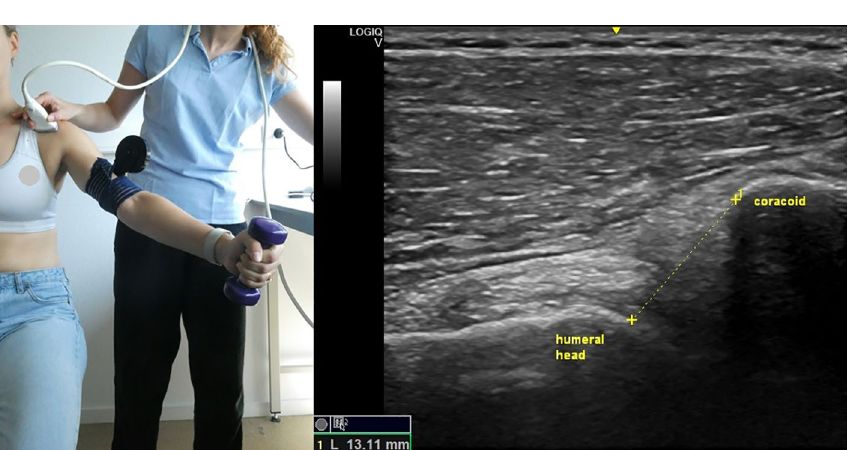
Figure 5. Left: position of the probe and the subject during the measurement of the coracohumeral distance at 60° with weights; right: measurement of the coracohumeral at 60° with weights. Photo on the left side by Anthe